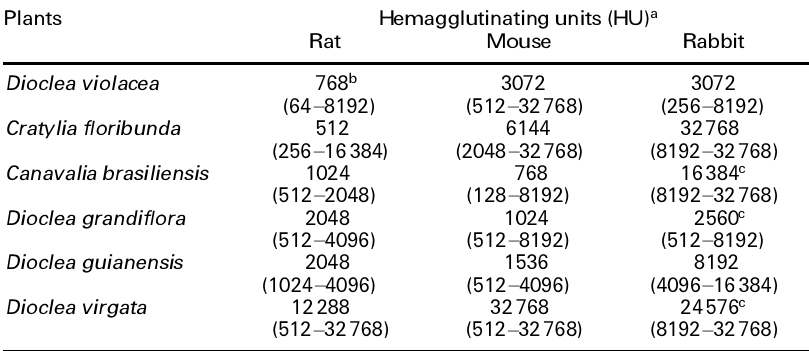
Table 3. Hemagglutinating activity of plant lectins on rodent erythrocytes Plants Dioclea